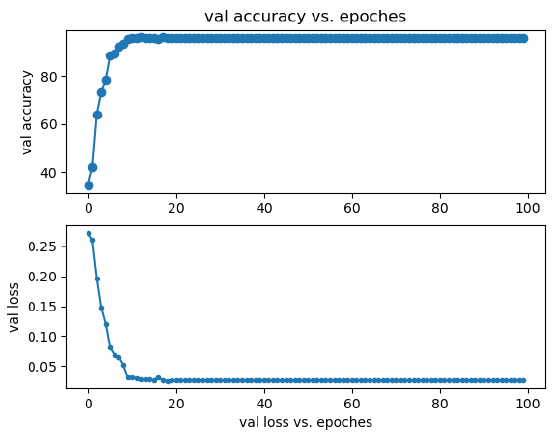
Figure 7. Three classifier training results.